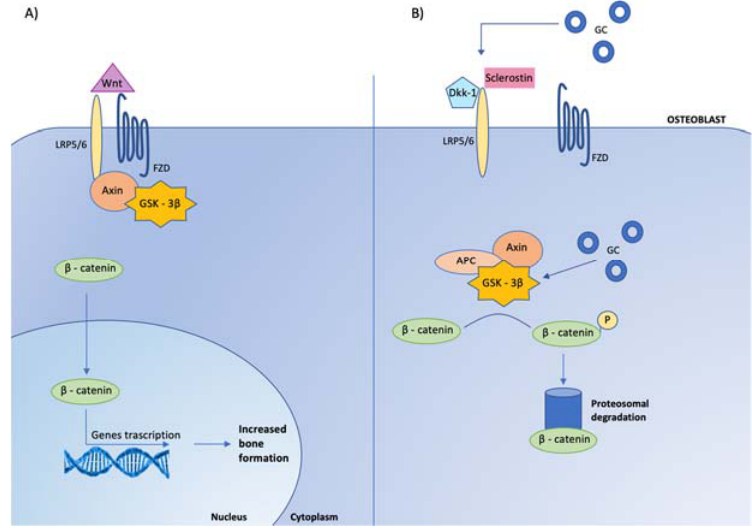
Figure 4. Effects of glucocorticoids on canonical Wnt signaling in osteoblasts. Glucocorticoids (GC) inhibit osteoblast cell differentiation by opposing Wnt/ β‐ catenin signaling. ( A ) In osteoblasts, when Wnt is present, it binds to specific receptors, called frizzled (FZD) to coreceptors, low ‐ density lipoprotein receptor related proteins (LRP ‐ 5/6), leading to the inhibition of glycogen ‐ synthase kinase ‐ 3 β (GSK ‐ 3 β ) activity, via its link with LRP ‐ 5/6 mediated by the protein Axin. When GSK ‐ 3 β is not active, stabilized β‐ catenin translocates to the nucleus, where it associates with transcription factors to regulate gene expression involved in osteoblast activity. ( B ) When Wnt is absent, the complex GSK ‐ 3 β‐ Axin ‐ Adenomatous Polyposis Coli (APC) is activated, leading to β‐ catenin phosphorylation (P) and consequently to its degradation by ubiquination (proteosomal degradation). The Wnt ‐β‐ catenin signaling pathway is regulated by several inhibitors, among which are Dickkopf ‐ related protein 1 (Dkk ‐ 1) and sclerostin, that prevent Wnt from binding to its receptor complex. Glucocorticoids enhance the expression of Dickkopf and sclerostin by osteocytes and maintain GSK 3 ‐β in an active state, leading to the inactivation of β‐ catenin.